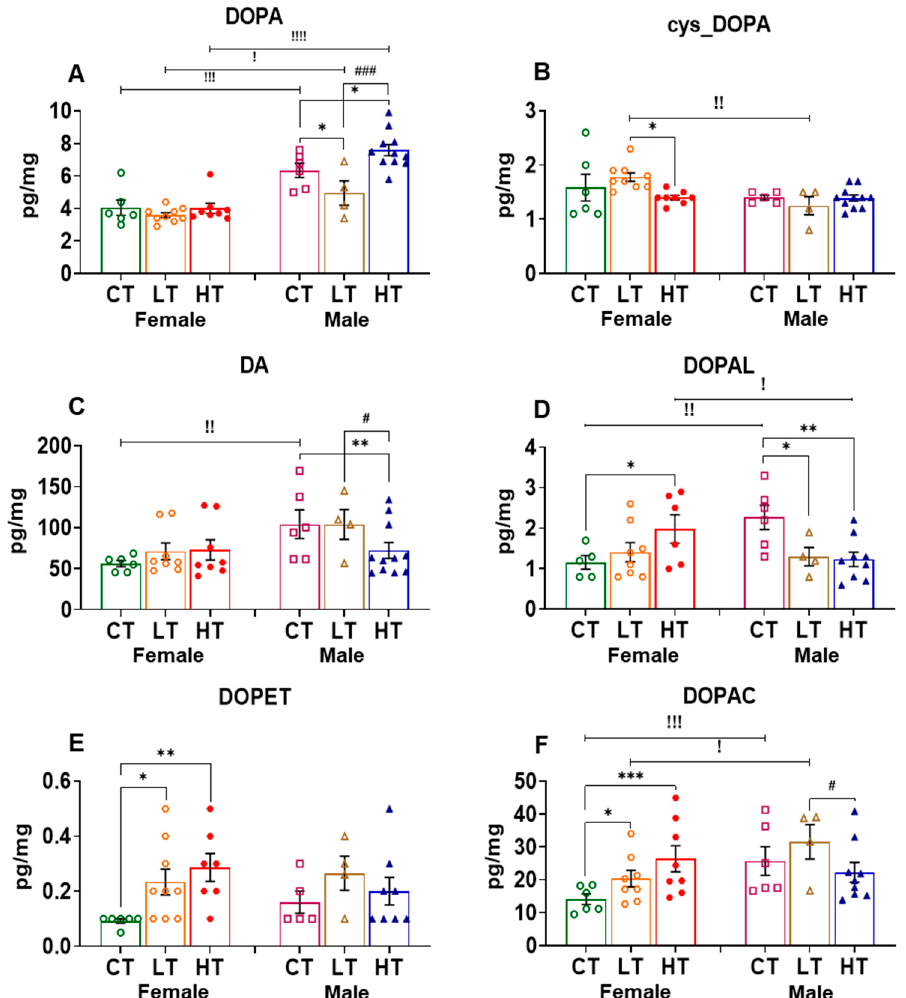
Figure 5. Level of dopamine and its metabolites in the hippocampus (HIP). ( A ) DOPA, ( B ) cys_DOPA, ( C ) DA, ( D ) DOPAL, ( E ) DOPET, and ( F ) DOPAC in female and male METH rats after 30 days of withdrawal from METH SA. * p < 0.05, ** p < 0.01, *** p < 0.001. # p < 0.05, ### p < 0.001. ! p < 0.05, !! p < 0.01, !!! p < 0.001.